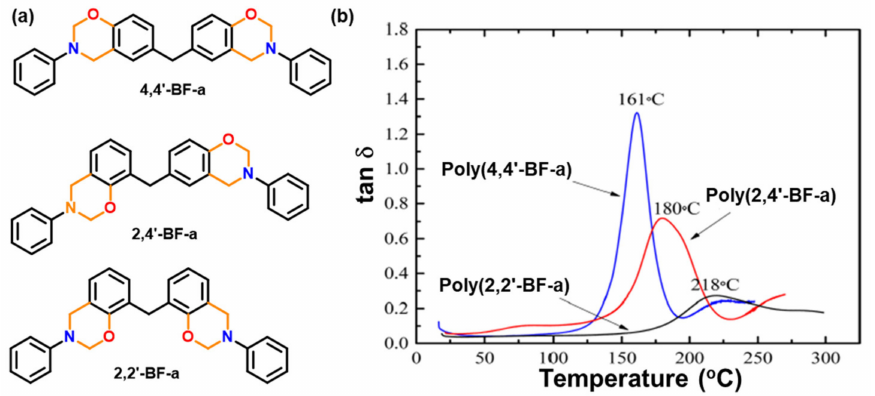
Figure 8. ( a ) Structures of isomeric BF-a monomers [152]. ( b ) Variation in tan δ of polybenzox- azines [152]. Copyright 2014. Reproduced with permission from American Chemical Society.